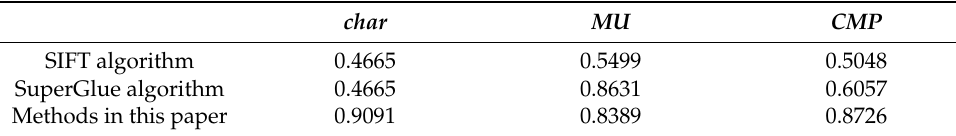
Table 5. Comparison of the comprehensive matching parameter of